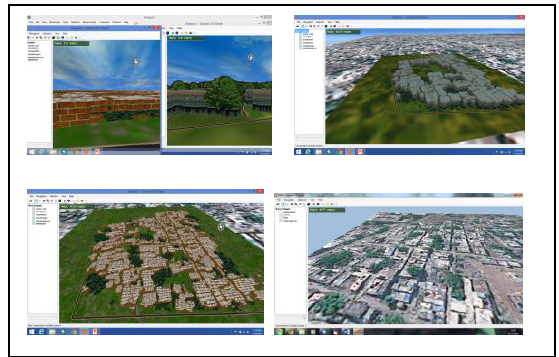
Figure 8 3D Scenarios Generated in